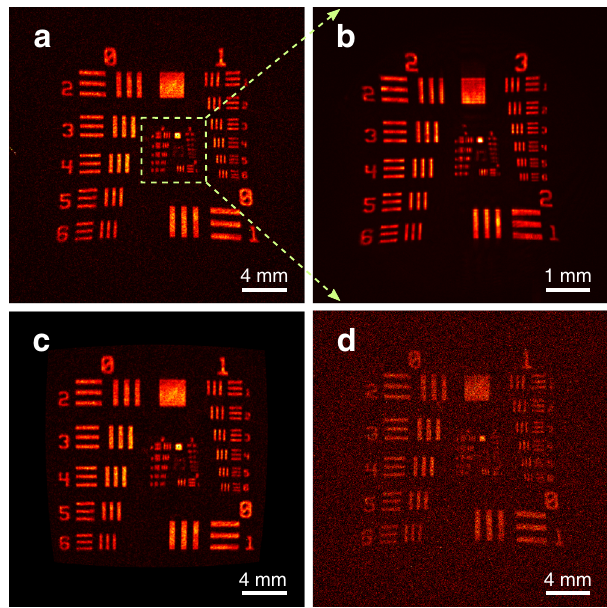
Fig. 5 MIR single-photon imaging. a MIR imaging for a resolution test target at the low-light-level illumination with 40 photons/pulse. The exposure time is set to be 180 s. b Enlarged object image with a zoom factor of 4, leading to an improved spatial resolution of about 31 μ m. c Corrected image for the pincushion distortion. d Ultra-sensitive imaging at the single-photon operation with 1 photon/pulse. The exposure time is set to 600 s. Note that all the images are acquired by a highly- sensitive EMCCD.